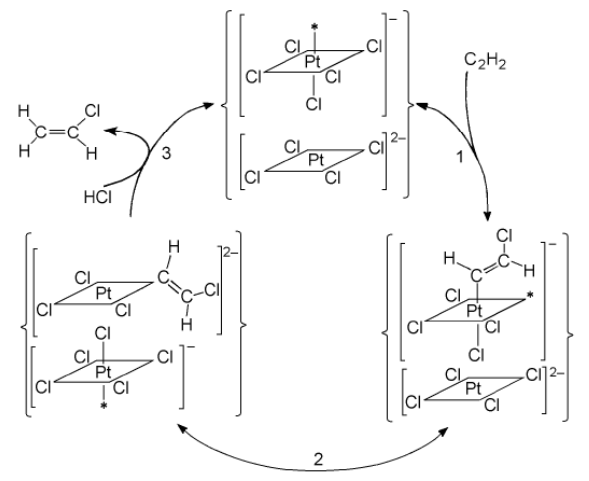
Figure 13. Catalysis mechanism of acetylene hydrochlorination over the Pt catalyst [96].